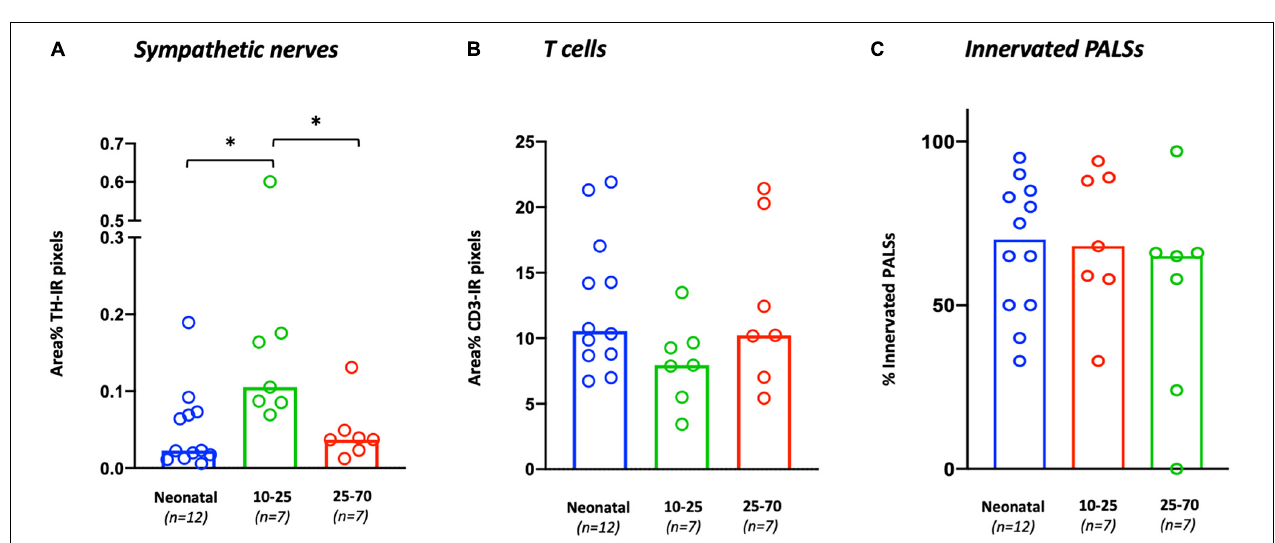
FIGURE 1 | Microscopic images of a normal spleen. (A) Overview image of a splenic sample of a patient from the 10–20 years group (HE staining). White and red pulp can be clearly distinguished as well as vascular structures and connective tissue structures such as trabeculae. (B) Close up image of the boxed splenic region in (A) , showing normal splenic pulp morphology with clear white and red pulp areas (HE staining). (C) Similar region as in (B) , showing the presence of T and B cells (CD3 and CD20, respectively) in periarteriolar lymphatic sheaths (PALSs) and follicles, respectively. BV, blood vessel; C, capsule; WP, white pulp; RP, red pulp; T, trabecula.